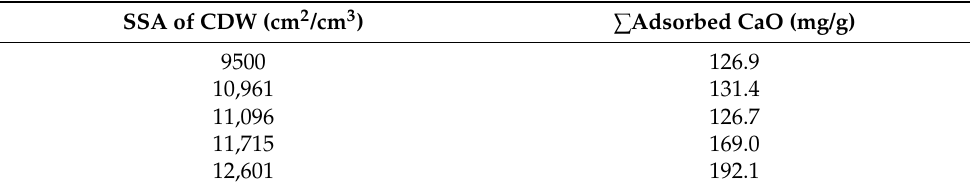
Table 3. Lime adsorption of CDWs.